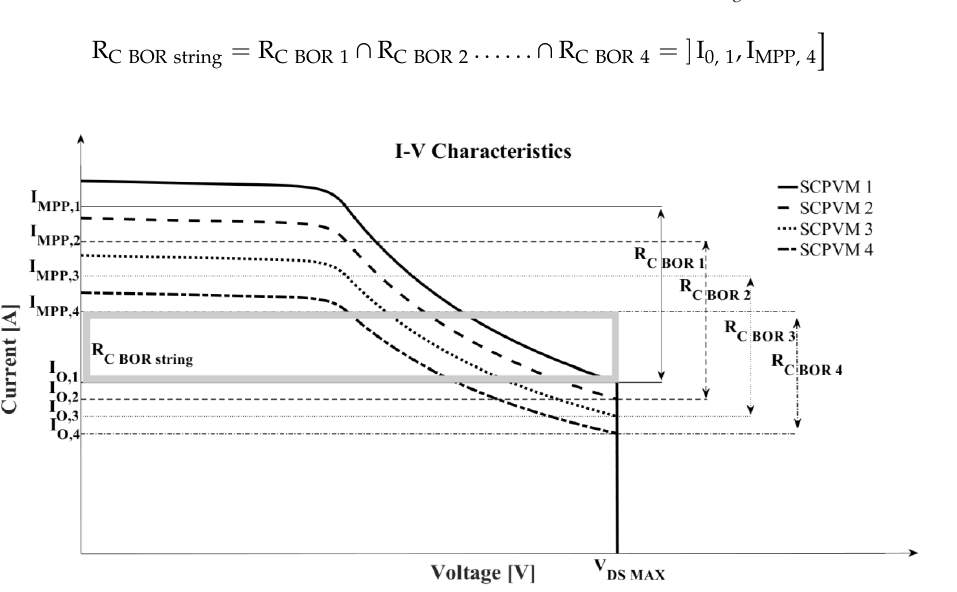
Figure 7. I-V characteristics of individual SCPVMs (Case A).